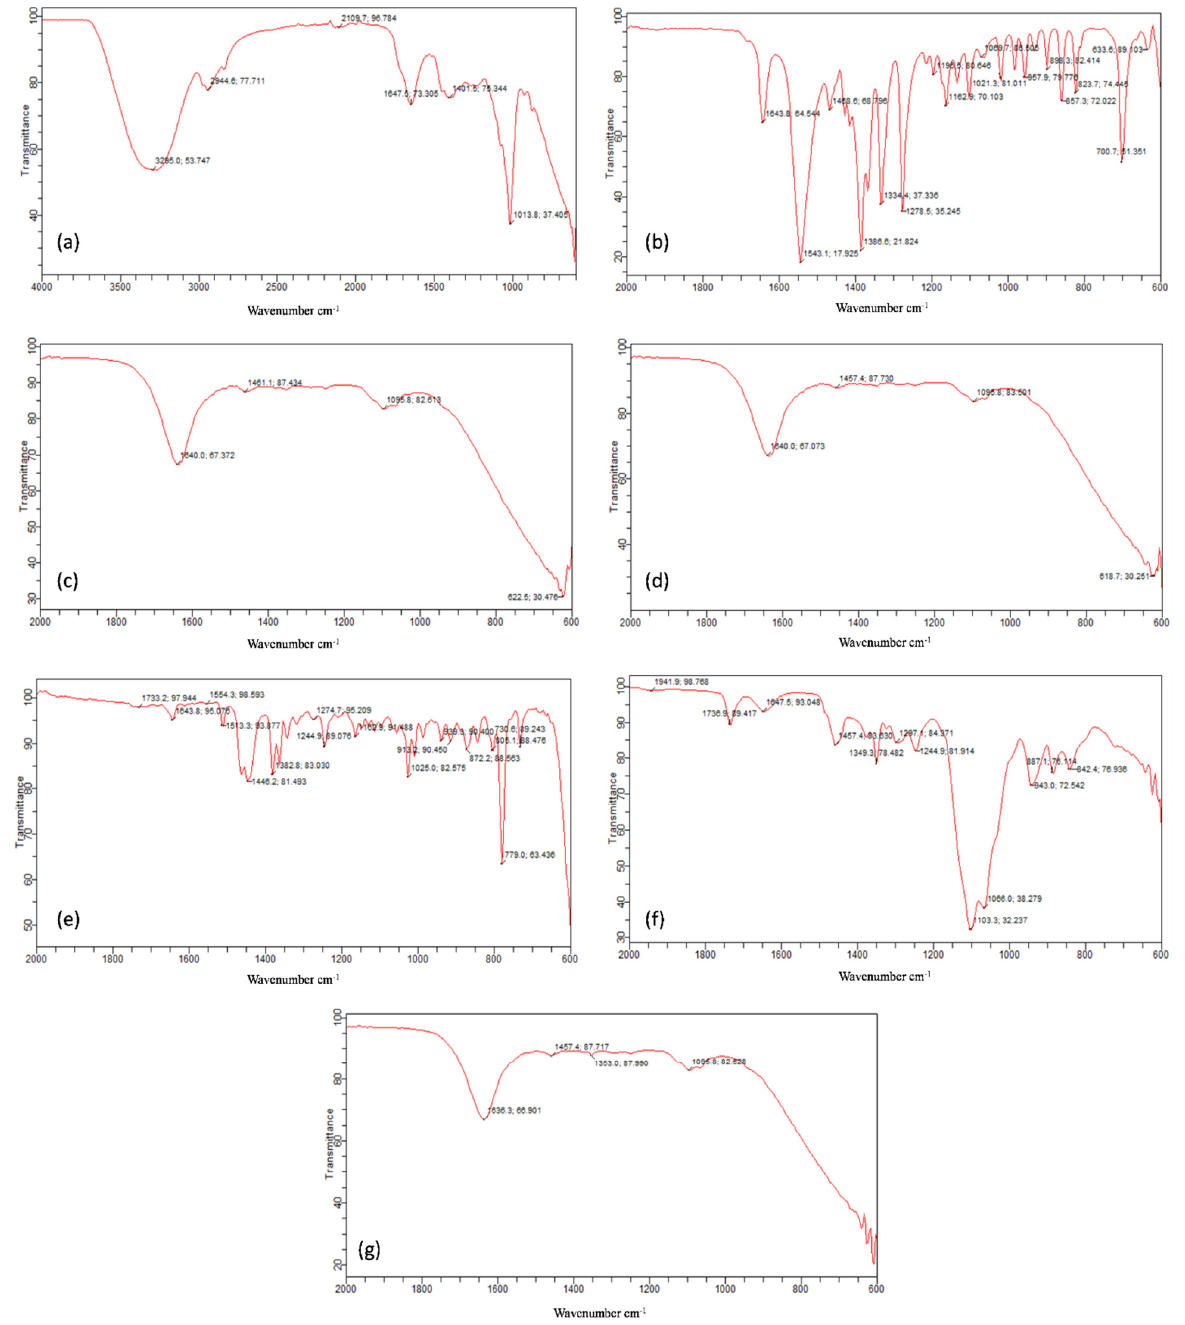
Figure 2. Compatibility studies between excipients and topical gels depicted through FTIR spectra of ( a ) pure extract, ( b ) pure drug, ( c ) drug and extract loaded gel, ( d ) drug loaded gel, ( e ) pure Frankincense oil, ( f ) Smix and ( g ) extract loaded gel.